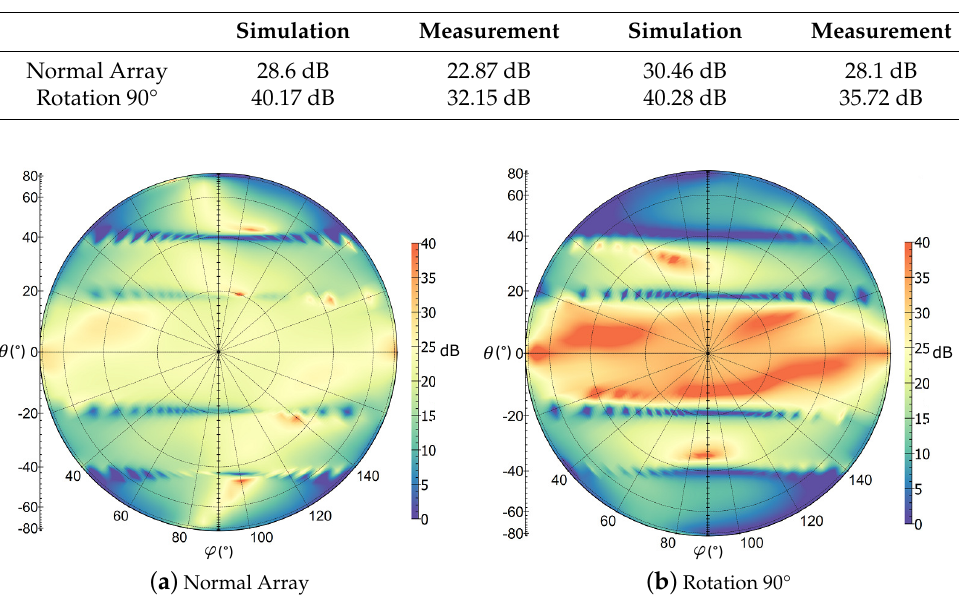
Figure 16. Measured cross-polar suppression @ f 0 = 1.325 GHz. Uniform amplitude and phase distribution. Horizontal polarization.